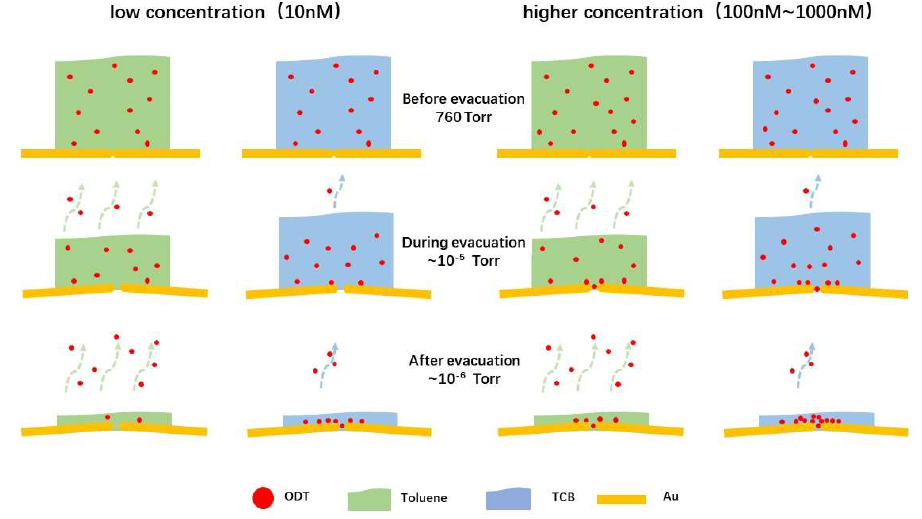
Figure 7. Schematic illustrations depicting solvent dependence of molecular adsorption on Au junctions during evacuation.